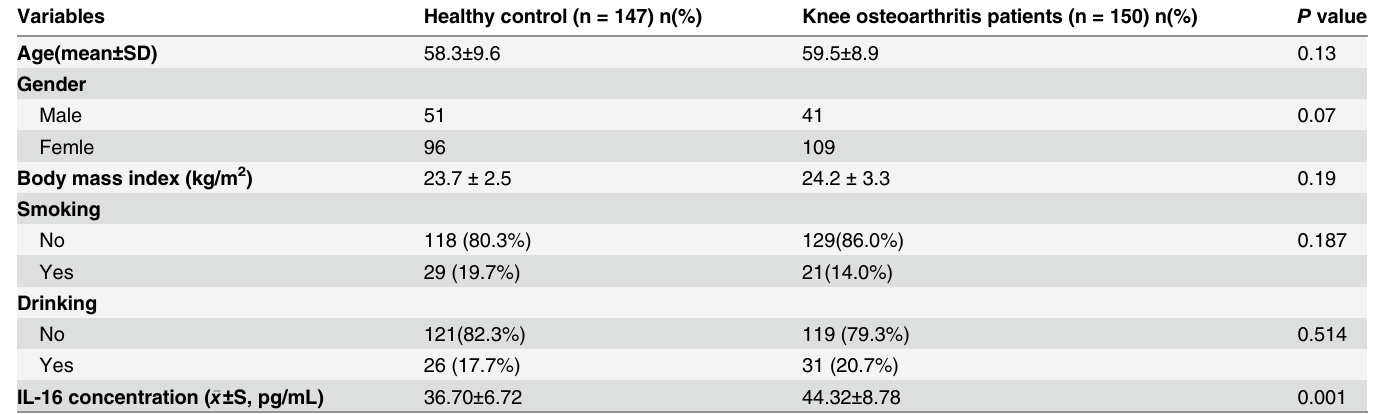
Table 2. Demographic characteristics of the study